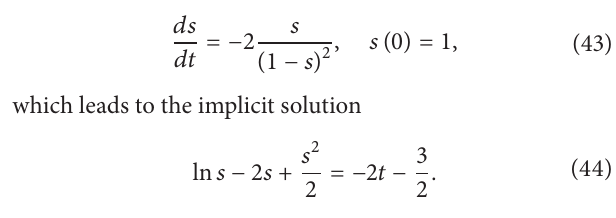
Use the 𝜖 -inequality: 2|𝑎𝑏| ≤ (1/𝜖)𝑎 2 + 𝜖𝑏 2 , 𝜖 > 0 to estimate the term which arises in the right-hand side of